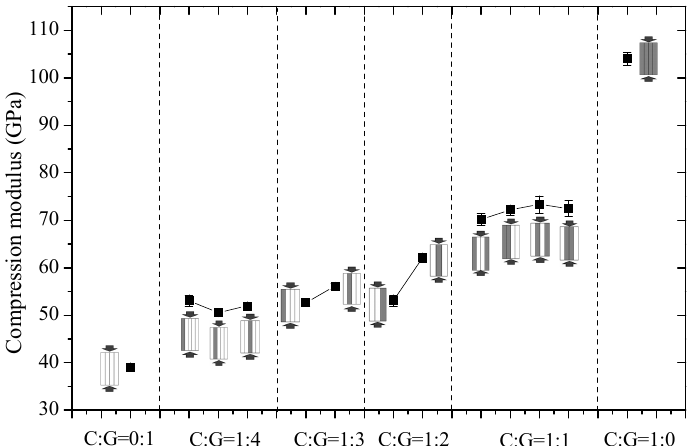
Figure 3. Compression modulus of different stacking sequences with various C/G ratios.